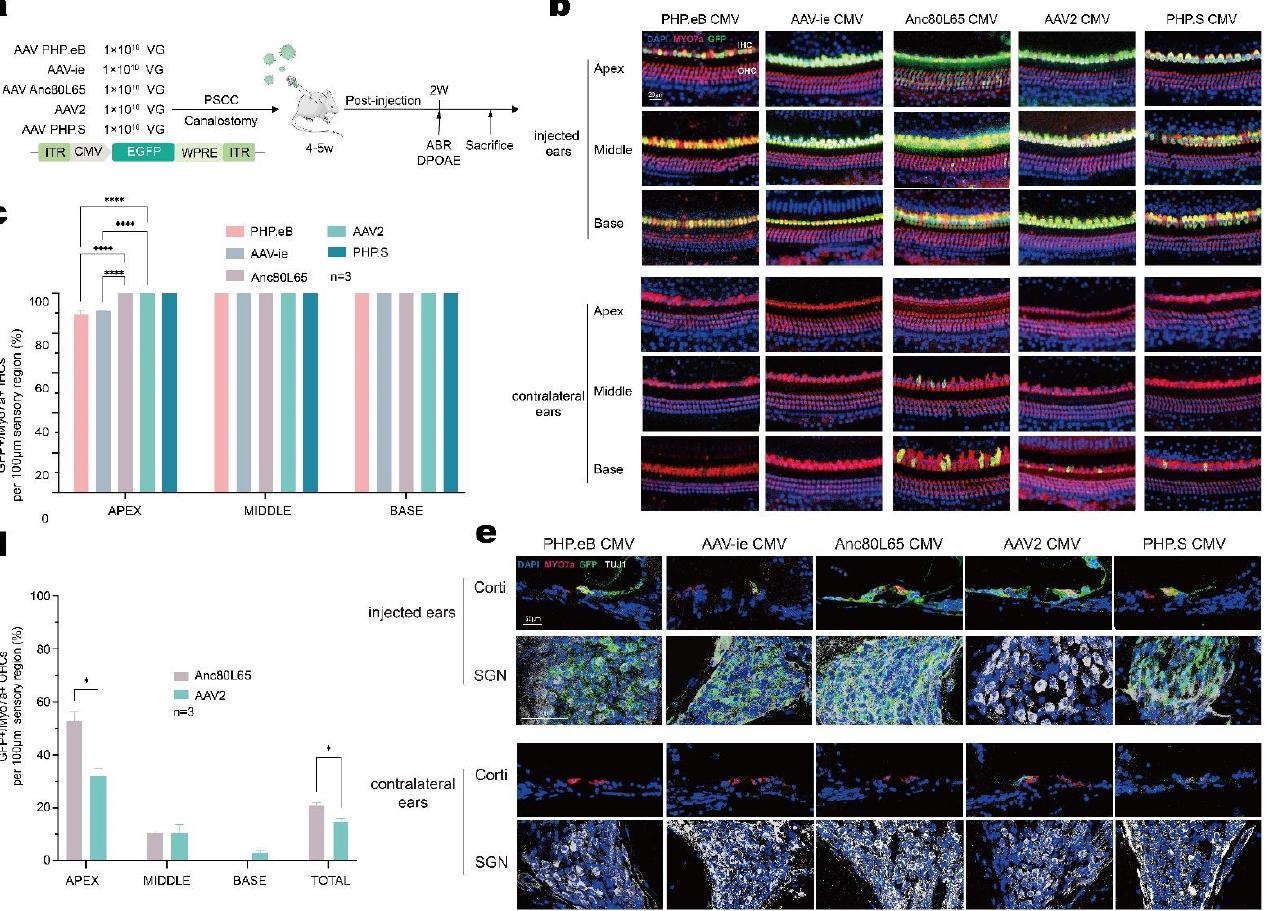
Figure 5. In vivo transduction of cochlear cells with AAV-PHP.eB, AAV-ie, Anc80L65, AAV2, and PHP.s in adult mice (4 – 6 weeks old). ( a ) Experimental design of the in vivo cochlear transduction. ( b ) Representative high-magnification images of the apex, middle, and base with different AAV vectors (1.0 × 10 13 VG/mL). ( c , d ) Quantitative comparison of IHC transduction efficiency ( c ) and OHC transduction efficiency (d) in the injected ears assessed in 100 µ m segments across different regions of the cochlea (apex, middle, and base). ( e ) Representative images of the organ of Corti and TUJ1-positive SGNs. Two-way ANOVA with Bonferroni correction was performed for multiple comparisons for cochlear HC transduction. * p < 0.05; **** p < 0.0001. According to the immunofluorescence results, one row of IHCs and three rows of OHCs were arrayed regularly across the entire length of the cochlea in both ears, an